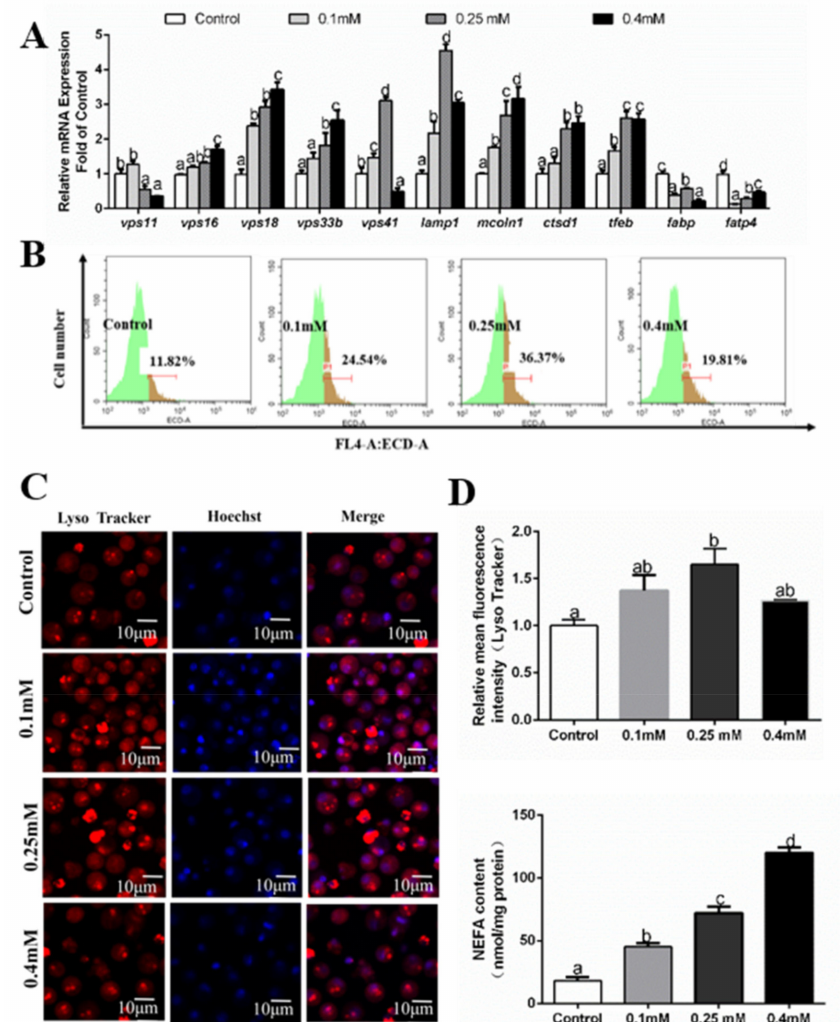
Figure 6. E ff ects of 12 h oleic acid (OA) incubation on autophagosomes in hepatocytes of P. fulvidraco. ( A ) E ff ects of 12 h OA incubation on the mRNA levels of autolysosome-related genes; data (mean ± SEM, n = 3) were expressed relative to expression of housekeeping genes ( b2m and rpl7 (M = 0.2456)). ( B ) The e ff ect of 12 h OA incubation on intracelluar autolysosomes demonstrated by flow cytometry analysis of the presence of Lyso Tracker-stained intracellular autolysosomes. ( C ) Representative confocal microscopy image of hepatocytes co-stained with Hoechest (blue) and Lyso Tracker (red) after 12 h OA incubation. ( D ) The e ff ect of 12 h OA incubation on intracelluar autolysosomes demonstrated by flow cytometric analysis of red (FL4) mean fluorescence intensity. ( E ) E ff ects of 12 h OA incubation on NEFA content. Letters ( a–d ) denote significance, p <